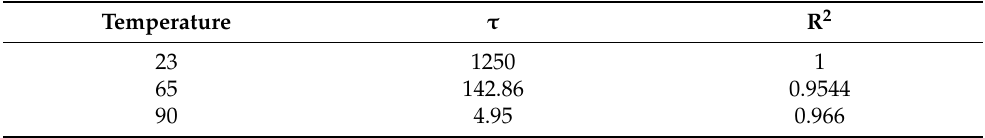
Table 6. Coefficients of regression